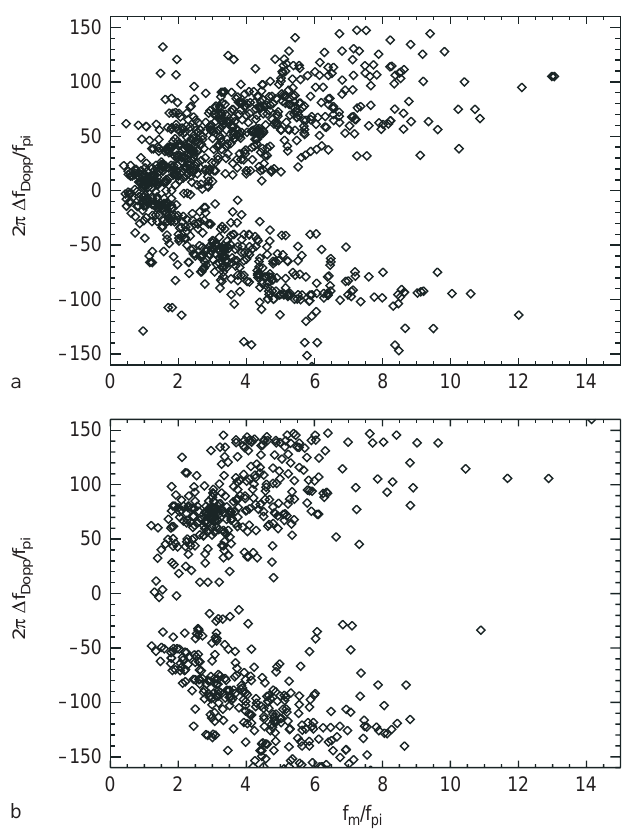
Fig. 4a, b. Scatter plot of the Doppler frequency (Eq. 7) versus the centre frequency f m (these frequencies are normalised to the local proton plasma frequency f pi calculated with the TNR density). a For the LF wave packets (region I in Fig. 2a); b for the isolated electrostatic structures (region III in Fig.